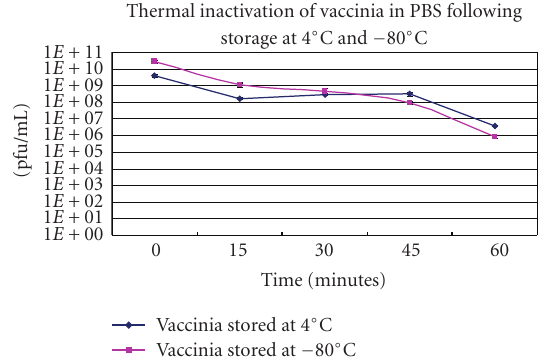
Figure 3: The inactivation of vaccinia virus stored at 4 ◦ C and − 80 ◦ C for one week and inactivated at 56 ◦ C in PBS, pH 7.4.